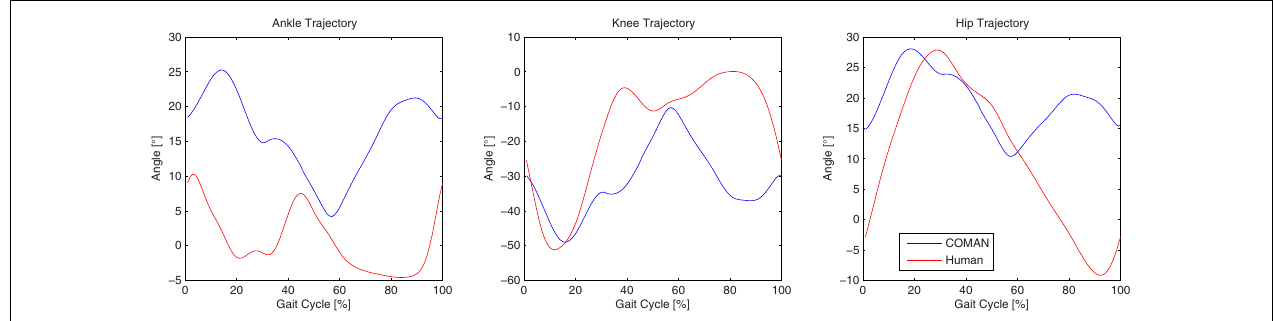
FIGURE 11 | Comparison between left ankle, knee, and hip trajectories of a human subject, and those of the COMAN robot walking human-like.